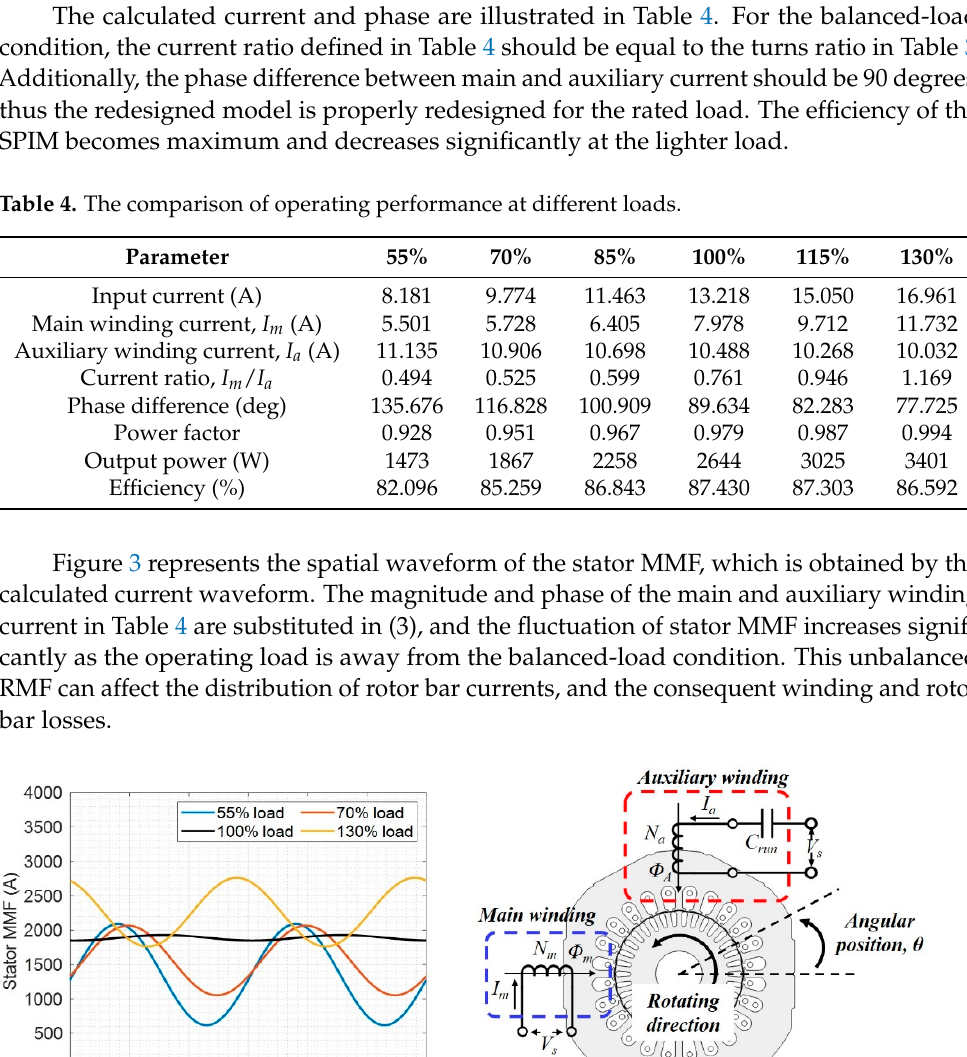
Figure 4. ( a ) The air-gap magnetic flux density and ( b ) the trajectory of the rotating magnetic field. As shown in Table 5, electromagnetic losses are calculated at the different loads. The stator copper loss and rotor bar loss tend to decrease monotonically when the value of load decreases. However, the decrease rate steadily becomes small and the stator copper loss at 55% load increases despite of the lighter load. The core-loss is insignificant to the change of loads since the air gap magnetic field is rarely affected by the unbalanced con- dition. The contribution of negative torque is notable, but the absolute value of the change rate with respect to the different loads is not quite distinct.